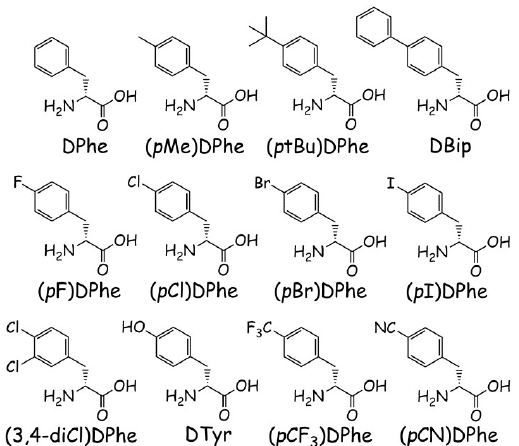
Figure 1. Structures and abbreviations of the amino acids used to replace the third amino acid in the peptide template Ac-His-Arg-Xxx-Tic-NH 2 .